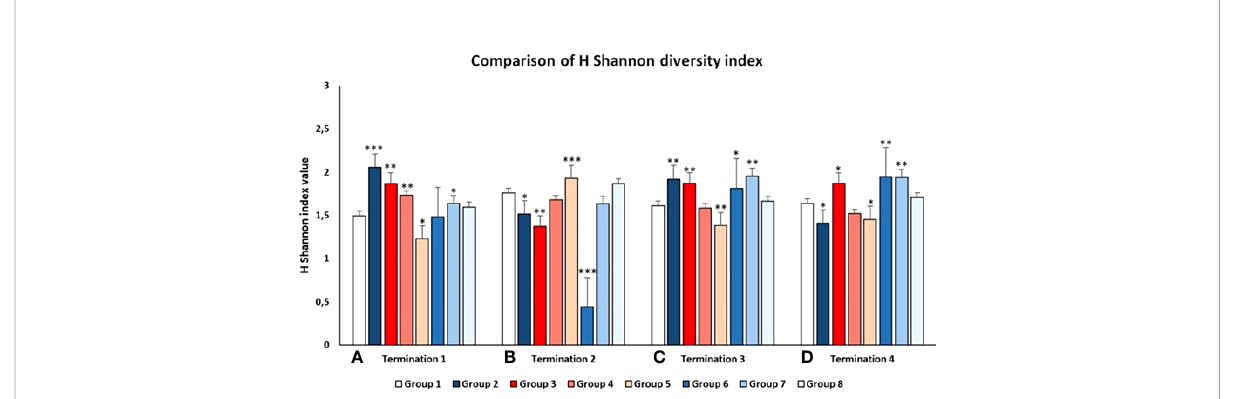
FIGURE 10 Shannon diversity index of the chicken intestinal microbiome in all tested Groups at 1 st (A) , 2 nd (B) , 3 rd (C) , and 4 th (D) terminations. Statistically signi fi cant changes relative to Group 1 are marked by asterisks, with * indicating p < 0.05, ** indicating p < 0.01, and *** indicating p <